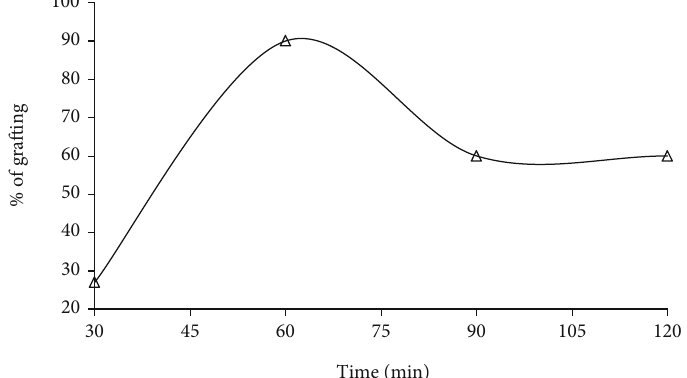
Figure 5: E ff ect of reaction period on the % of grafting and e ffi ciency. AN: 8ml, H of grafting.